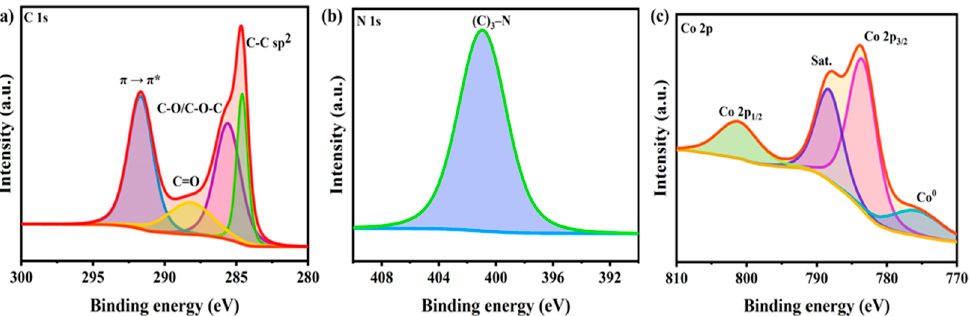
Figure 4. XPS spectra of 3% CNF-HZNPC. ( a ) C 1sa, ( b ) N 1s and ( c ) Co 2p.